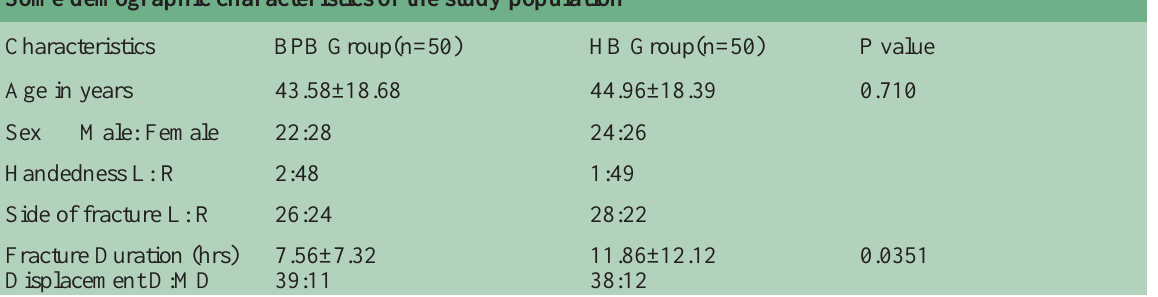
Table 2 Demographic characteristics of the study population Some demographic characteristics of the study